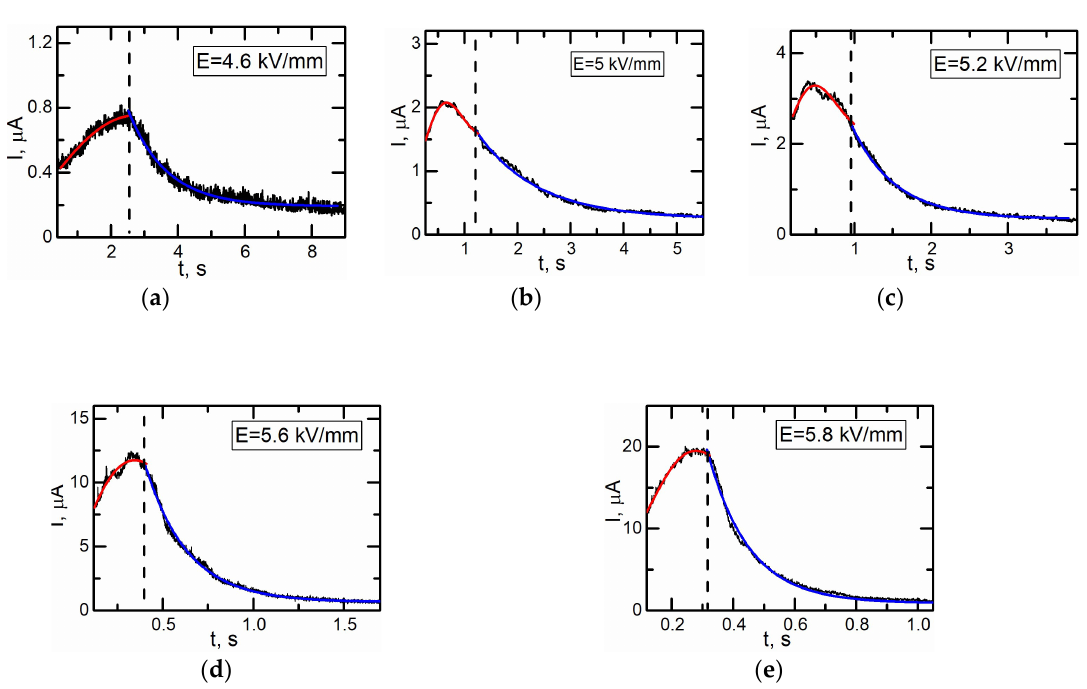
Figure 8. The switching currents for different external fields fitted by Equation (2). Field: ( a ) 4.6 kV/mm; ( b ) 5.0 kV/mm; ( c ) 5.2 kV/mm; ( d ) 5.6 kV/mm; and ( e ) 5.8 kV/mm.